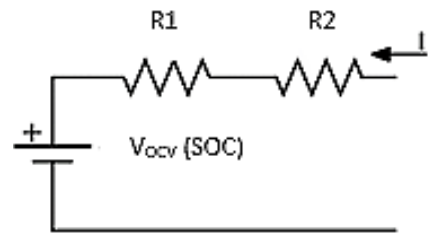
Figure 5. Simple RC battery model.